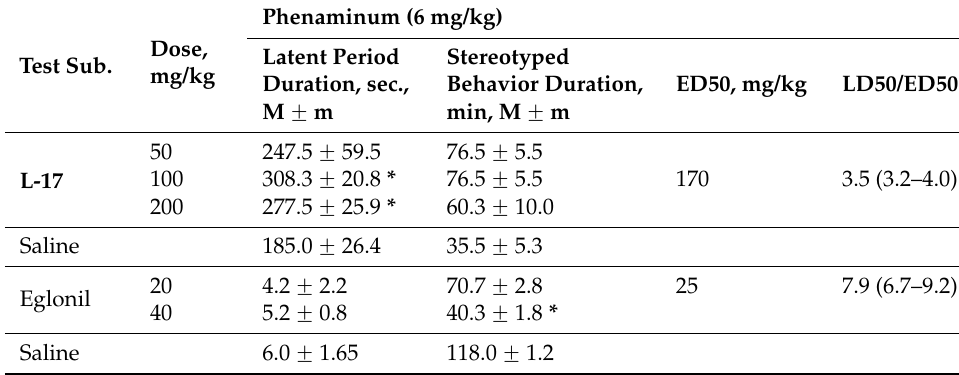
Table 4. Results of the amphetamine-induced locomotion test after administration of compound L-17 .